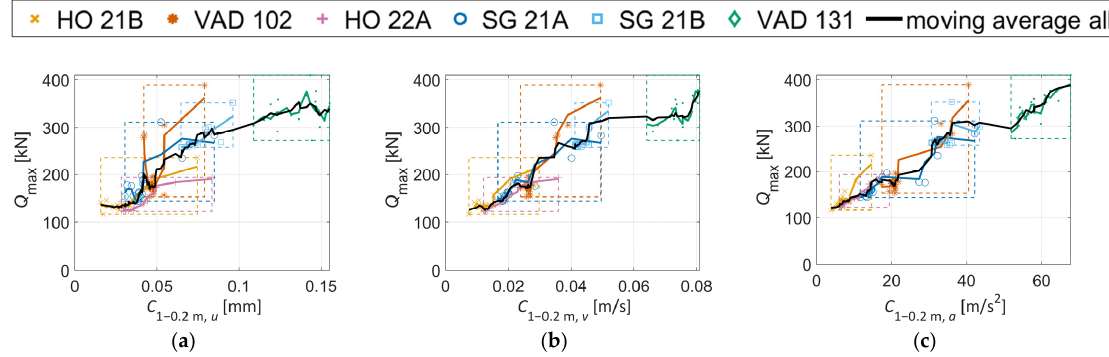
Figure 23. ( a – c ) Relation between simulated Q max and C 1 − 0.2 m, γ for six different crossing panels with calibrated track parameters. The black, continuous line presents a 7-points moving average filter through the cloud of all scatter points. Dashed boxes (with the corresponding color) cover the min-max domain of results for each crossing